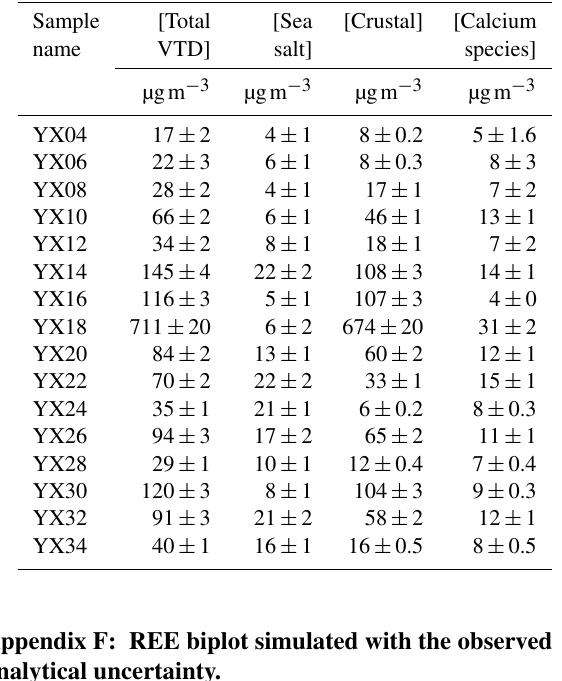
Table E2. PM 10 aerosol mass concentrations derived from chemical analyses with associated analytical uncertainties (95% confidence interval).